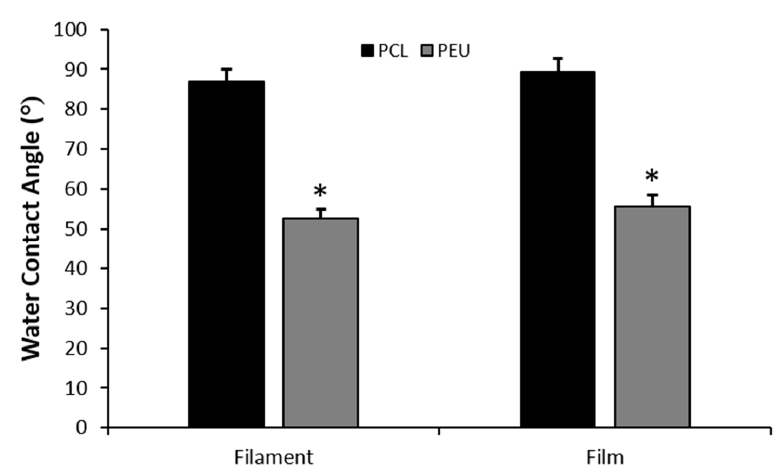
Figure 5. Average water contact angles for films and filaments of PCL and PEU scaffolds (* indicates p < 0.001, PEU vs. PCL; error bars represent standard error of mean, n = 5).